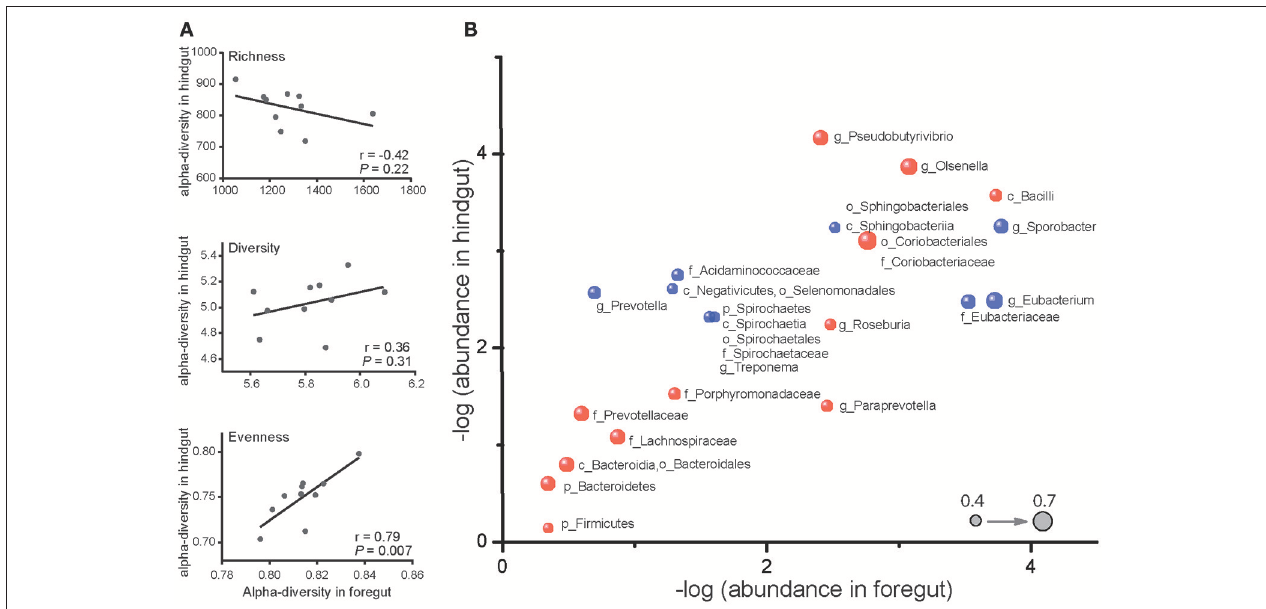
FIGURE 2 | Correlation of microbiota in foregut and hindgut. (A) Richness, diversity and evenness correlations between foregut and hindgut microbiota. (B) Correlations of bacterial taxa in foregut and hindgut. Horizontal axis and vertical axis represent the mean value of relative bacterial abundance in foregut and hindgut, respectively. Bubbles in blue represent the positive correlations and those in red represent the negative correlations; bubble size represented the correlation coefficient ( r ); only bacterial taxa with correlation coefficient ( r ) higher than 0.4 were shown. Bacteria at phylum (p), class (c), order (o), family (f), and genus (g) level were